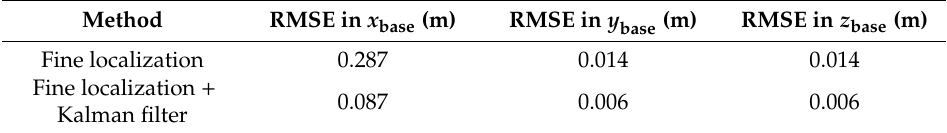
Table 1. Comparison of the fine localization errors with and without Kalman